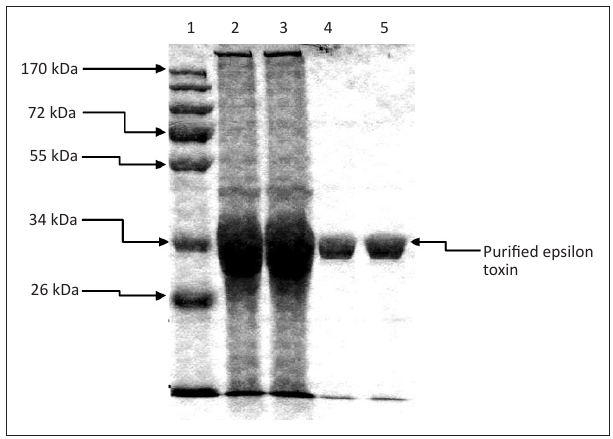
FIGURE 1: Sodium dodecyl sulphate-polyacrylamide gel electrophoresis analysis of the purified toxin